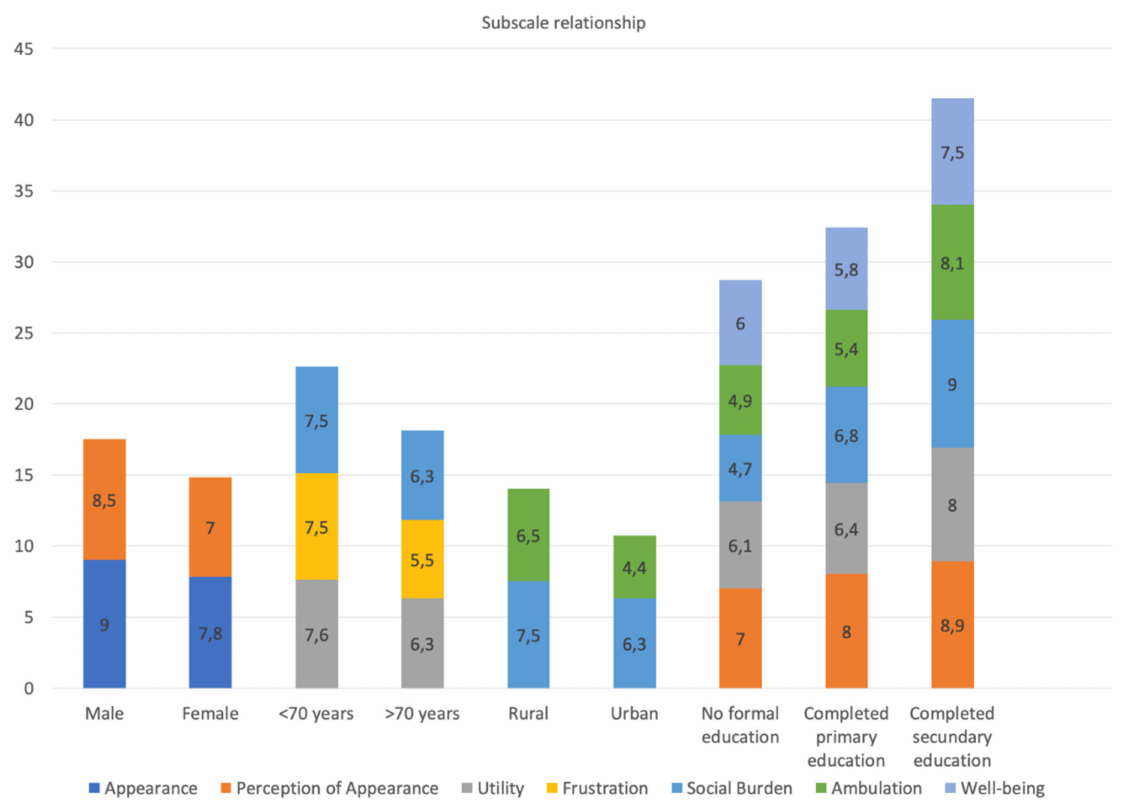
Figure 1. Relationship between statistically significant subscales and variables